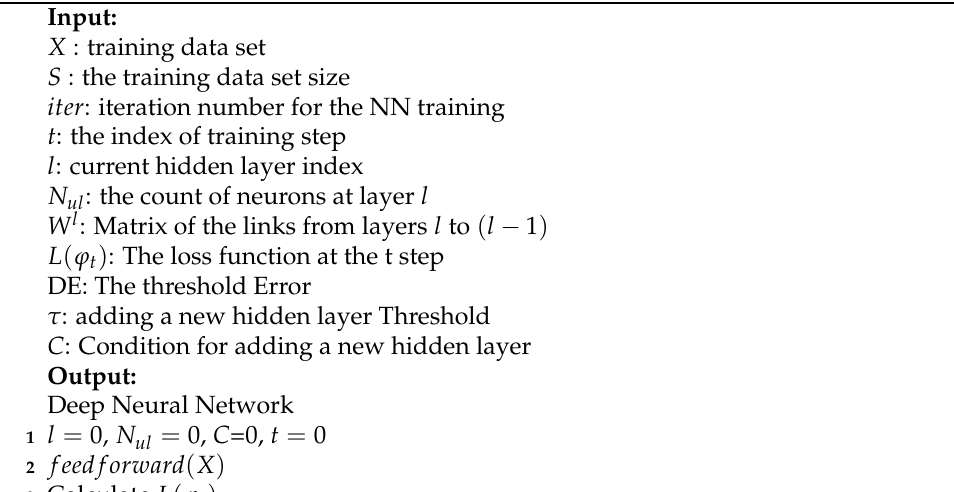
Algorithm 1: Cascade-Correlation Growing Deep Learning Neural